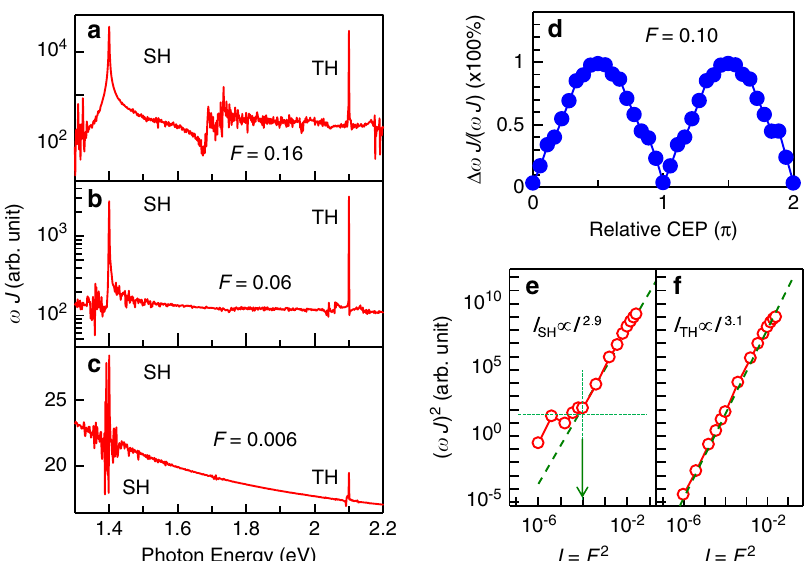
Fig. 4 Calculated spectra of SHG and THG. a – c Calculated spectra of ω J showing SHG and THG for light- fi eld (which is polarized parallel to the c- axis) F = 0.16 a , 0.06 b , and 0.006 c , respectively. d CEP dependence of the calculated SHG intensity [peak intensities of ω J at 1.4 eV (SHG)] for F = 0.1. e , f Calculated intensities of SHG e and THG f as a function of I = F 2 . The green dashed lines in e and f indicate I 2.9 e and I 3.1 f